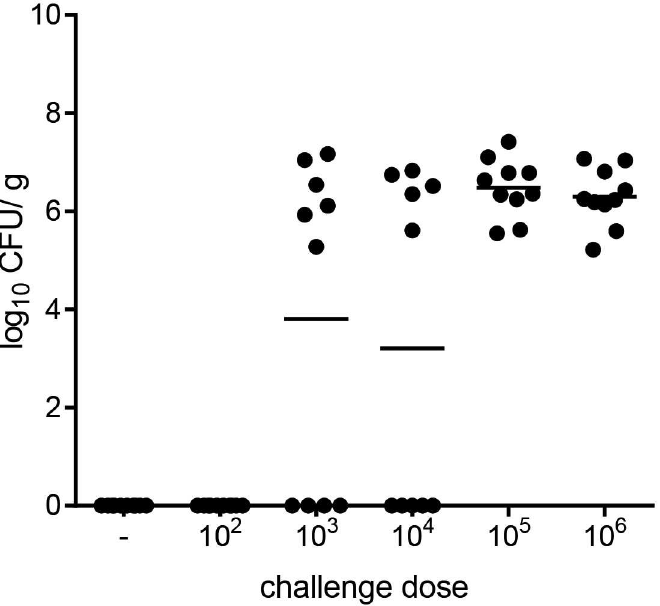
Fig 2. Determination of challenge dose of C . jejuni strain 81116. Chickens were orally inoculatedwith the indicateddose of C . jejuni strain 81116. Four days post-inoculation the number of C . jejuni in the chicken ceca was determinedby plate counting and expressed as colony forming units per gram cecal content (CFU/ g). Symbols represent individualanimal bacterial loads (log 10 CFU/ g), and bars represent the